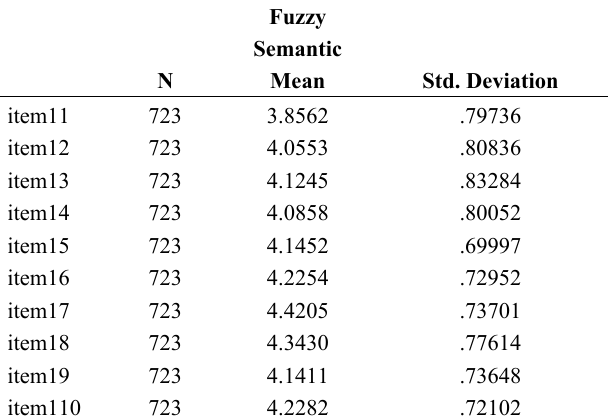
Table 5: The descriptive statistics of the second part